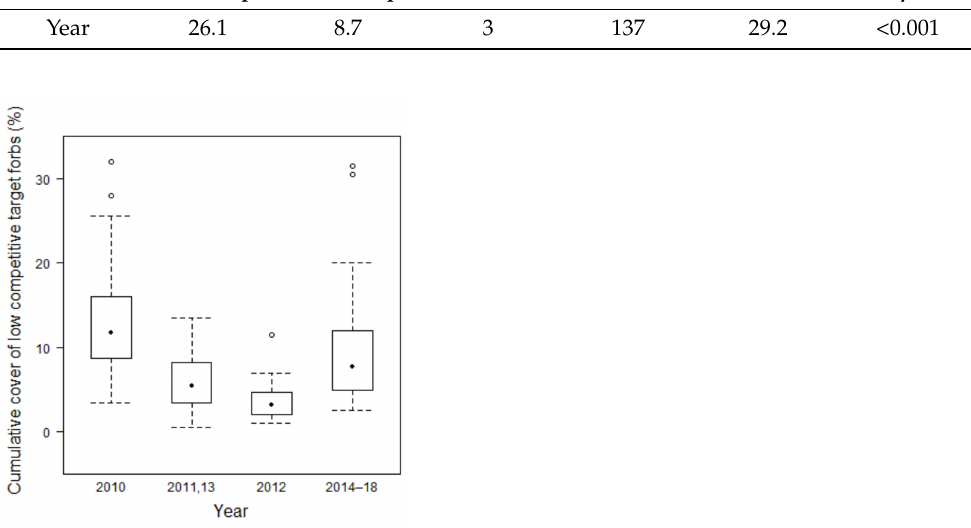
Figure A5. The minimal adequate model for the effect of time on the cumulative cover of low- competitive target forbs with different fertilization treatments between 2010 and 2018 (except